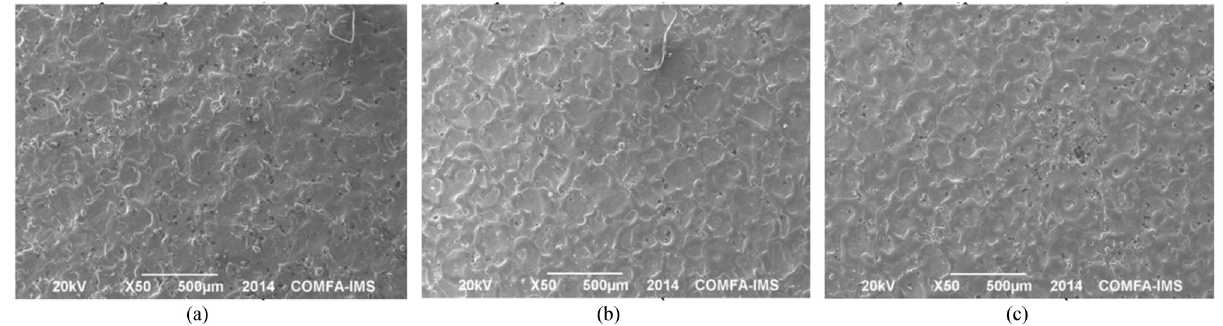
Figure 9: Topography of machined surface. ( a ) Topography of machined surface with 3 g/L, ( b ) topography of machined surface with 4 g/L, and ( c ) topography of machined surface with 5 g/L.